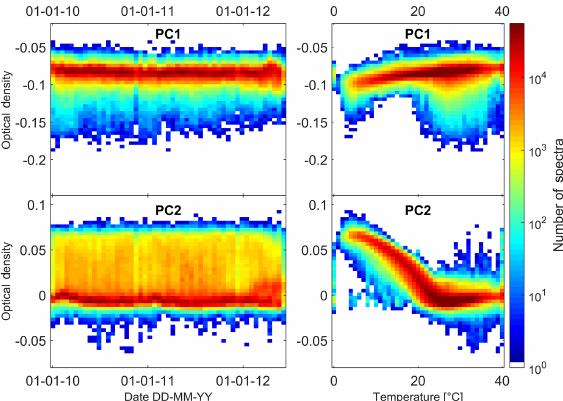
Figure D1. Peak-to-peak apparent optical density (e.g. peak-to-peak optical depth of the principal component times the fit coefficient) of the first and second principal components for instrument D2J2200 at Nevado del Ruiz.